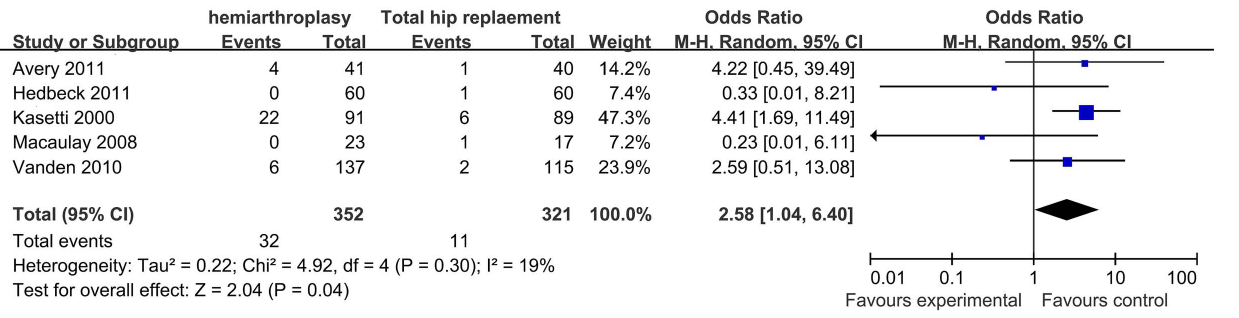
Figure 3. Statistical analysis of dislocation between HA (hemiarthroplasty) and THA (total hip arthroplasty) with Review Manager.